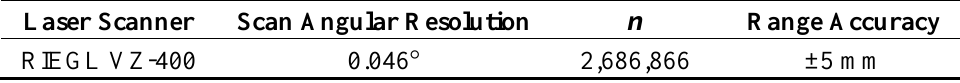
Table 1. Description of the point cloud